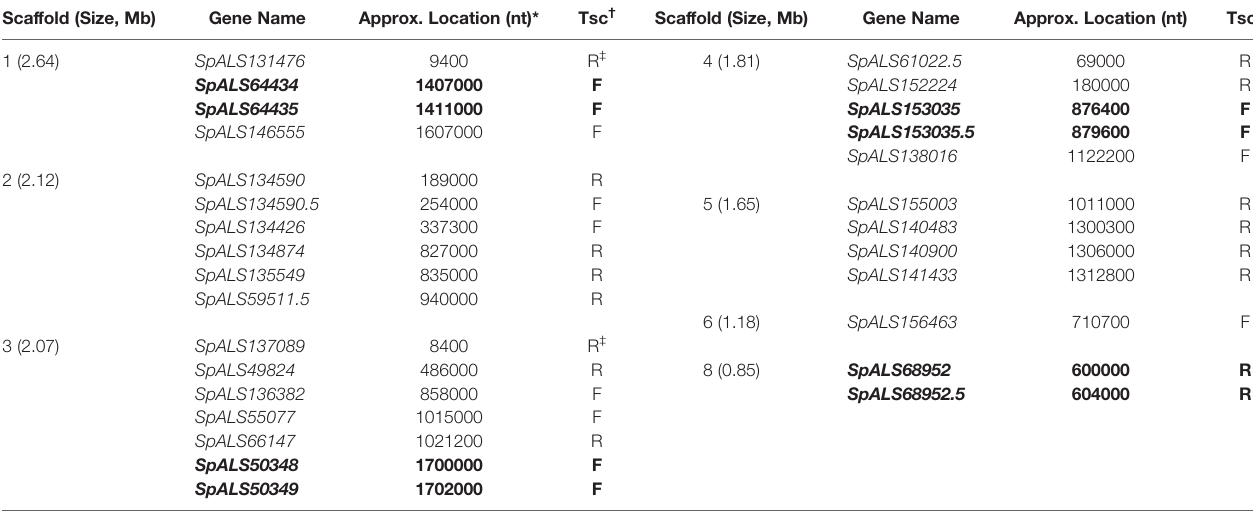
TABLE 2 | Physical location of ALS loci in the S. passalidarum NRRL Y-27907 genome. Scaffold (Size,